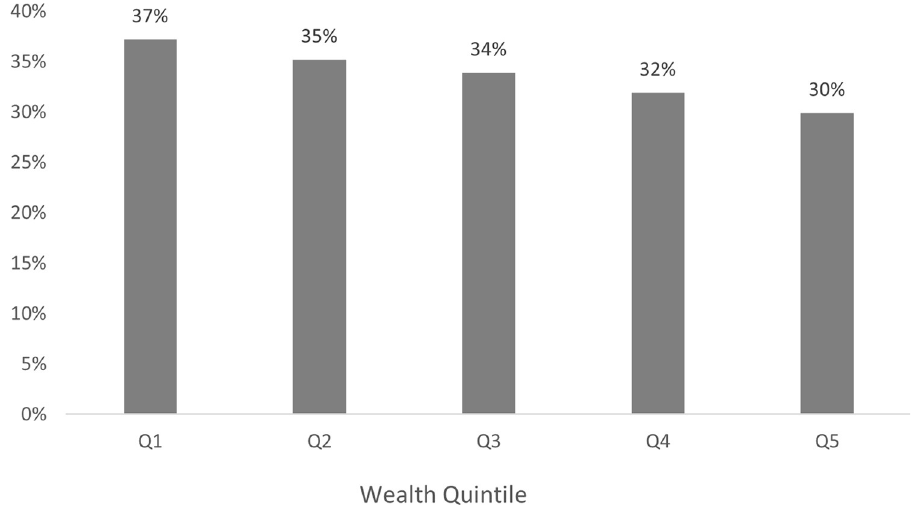
Fig 2. JKN households’ probability to obtain health care without OOP spending. Note: � Statistically significant at